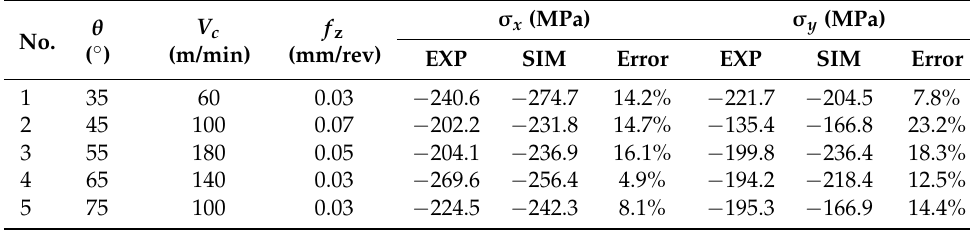
Figure 7. Experimental and simulated surface residual stress. Table 4. Experimental and simulated surface residual